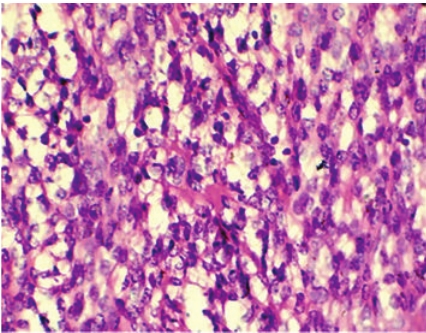
Figure 2: Tumor cells are of two populations. One population is of spindle cells. The other population of cells is round with clear cytoplasm (H&E × 400).